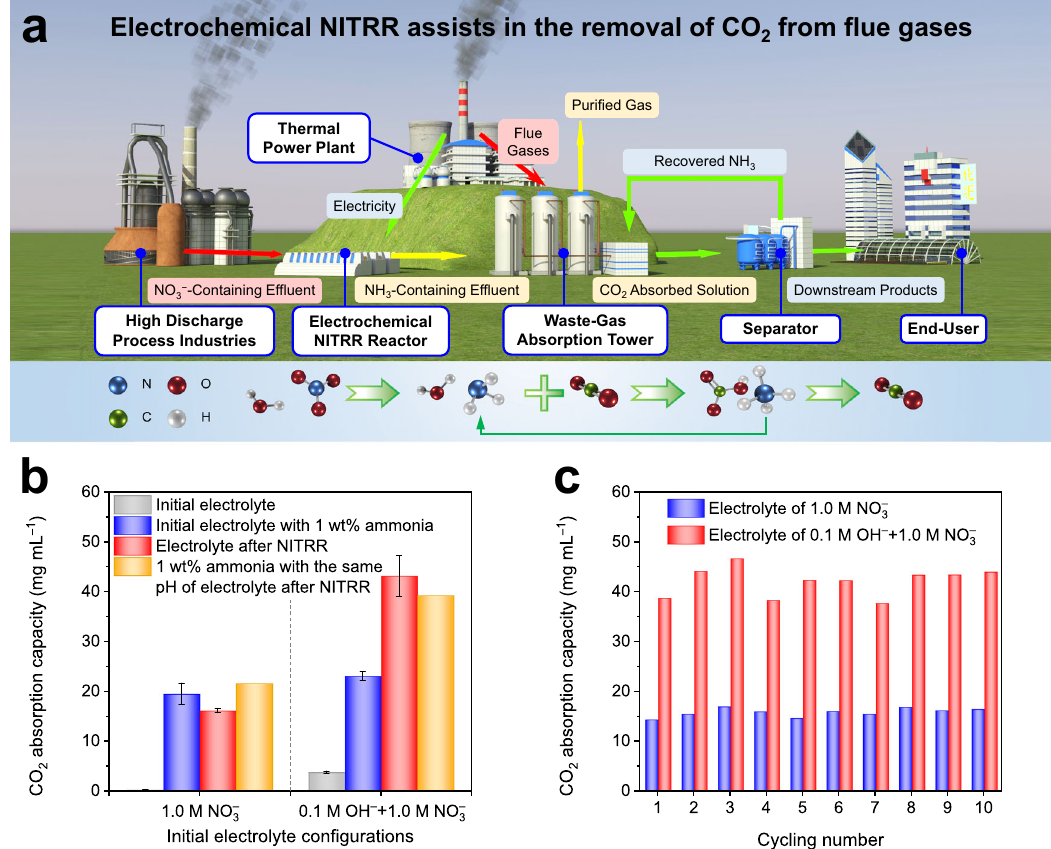
Fig. 6 | Electrochemical NH3 production for CO2 capture. a Schematic diagram of electrochemical NITRR assists in the removal of CO 2 from fl ue gases. b CO 2 capture capacity of different electrolyte con fi gurations. c CO 2 capture stability of